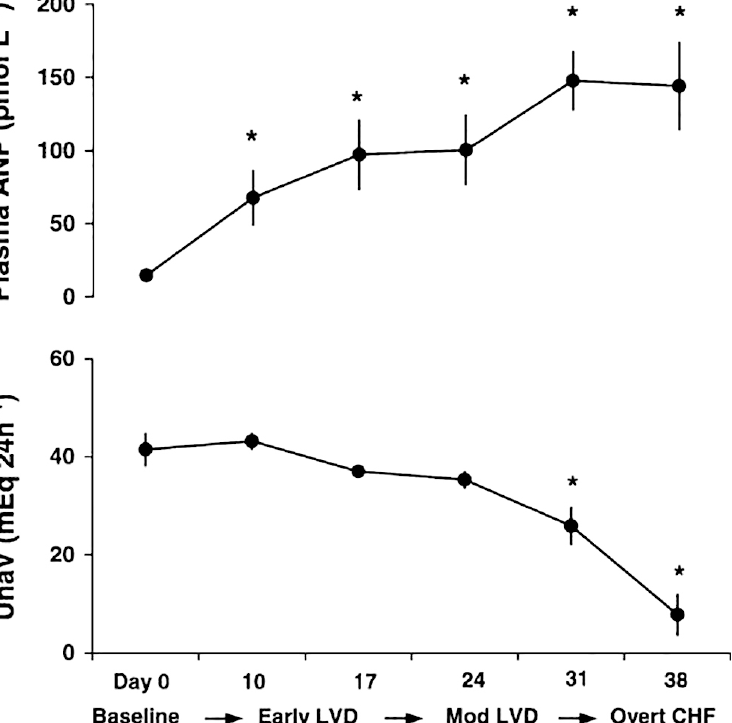
Figure 2. Tempora changes in circulating ANP and urinary sodium excretion (UNaV) in left ventricu- lar dysfunction (LVD) progression [30]. * p < 0.05 compared with the control